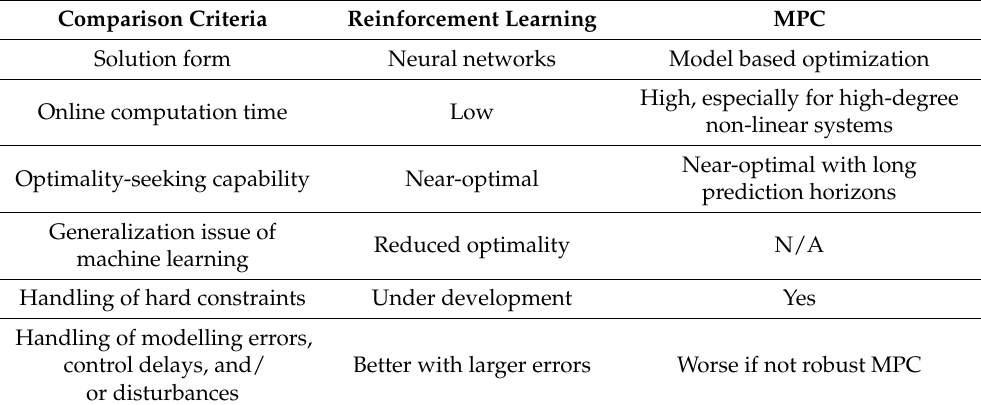
Table 4. Comparison of deep reinforcement learning and model predictive control for optimal control